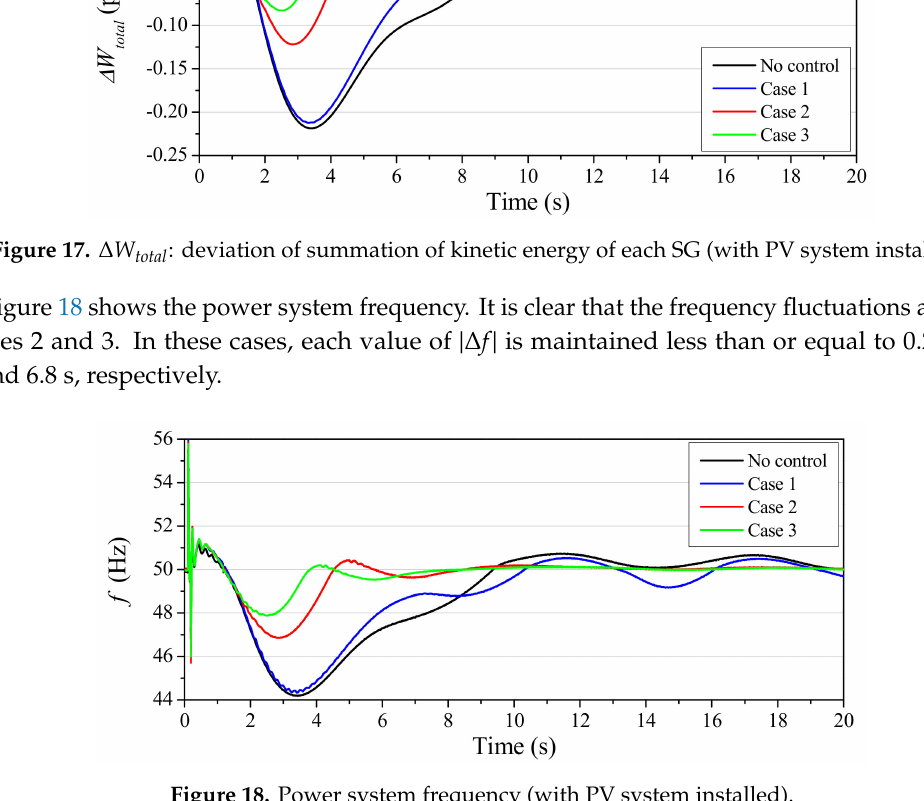
Figure 18. Power system frequency (with PV system